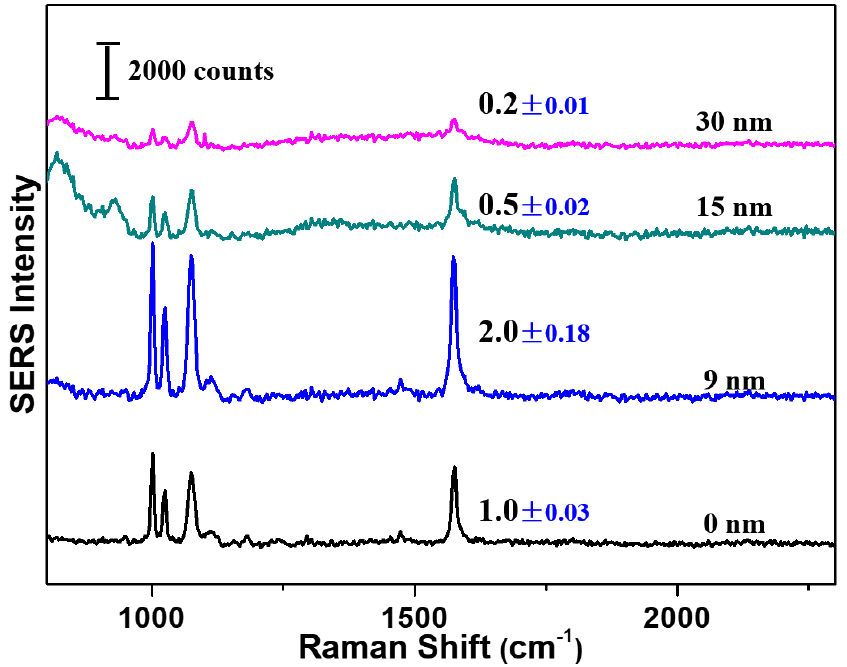
Figure 5. Dependence of surface-enhanced Raman spectroscopy (SERS) intensity on thickness of Ag cover. The relative intensity of each specimen is indicated nearby by the peak at 1573 cm −1 . The number on the right of each curve shows the thickness of Ag cover.